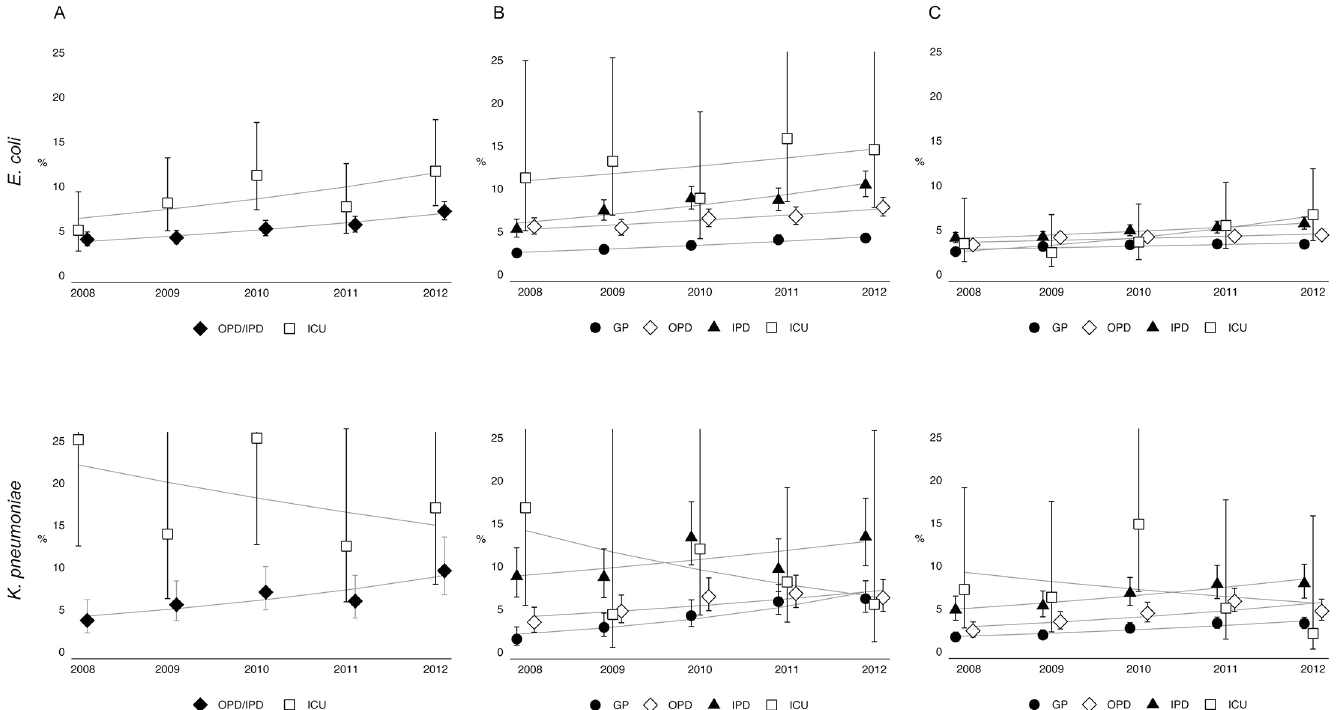
Fig 3. The proportion (in %) extended-spectrum cephalosporin-resistant Escherichia coli and Klebsiella pneumoniae isolates, for blood isolates (A), male urine isolates (B) and female urine isolates (C), per patient setting (general practitioner [GP], outpatient department [OPD], inpatient department [IPD] and intensive care units [ICU]), from 2008 – 2012, ISIS-AR, the Netherlands. The point-estimates are generated with a generalized estimation equation (GEE) for log-binominal regression, including time in years, and patient characteristics, including age, gender, and geographic region. The error bars represent the 95% confident intervals of each of the point-estimates. To produce plots with comparable y-axis, the upper error bar is cut-off for some of the point-estimates.